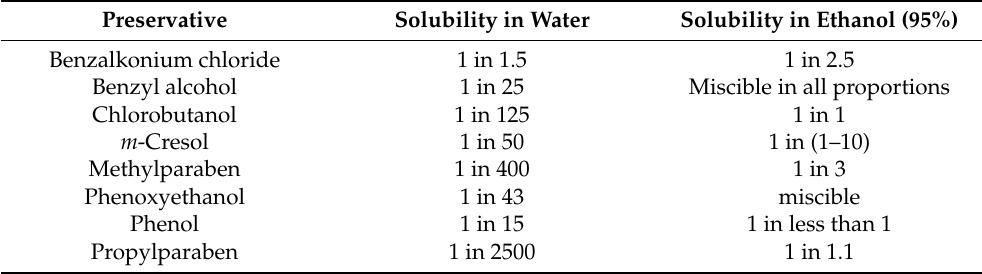
Table 7. Solubility (20 ◦ C) of antimicrobial preservatives in water and ethanol (95%) [14,24]. Units for solubility are reported according to Rowe et al., 2006